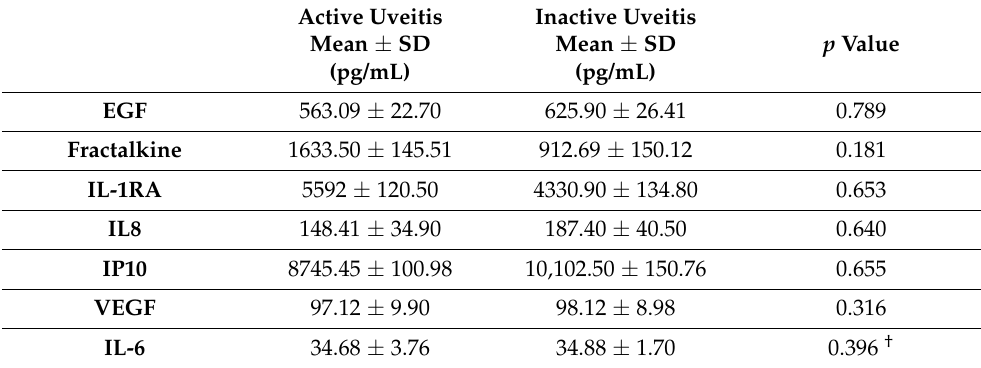
Table 2. Cytokine and chemokine tear levels according to uveitic activity.